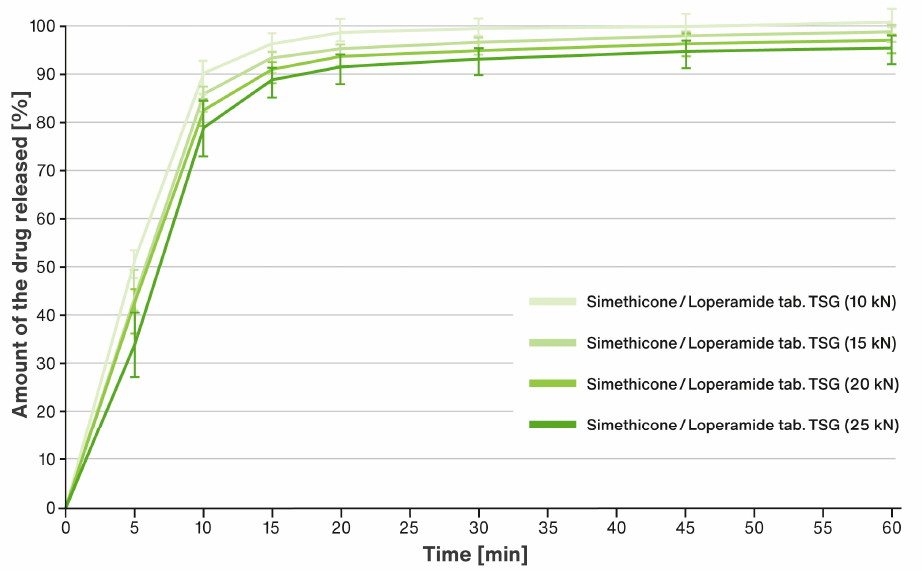
Figure 5. Comparison of dissolution rate of loperamide hydrochloride from liquisolid formulations compressed under various compression forces. Means of n = 6; SD is indicated by the error bars.